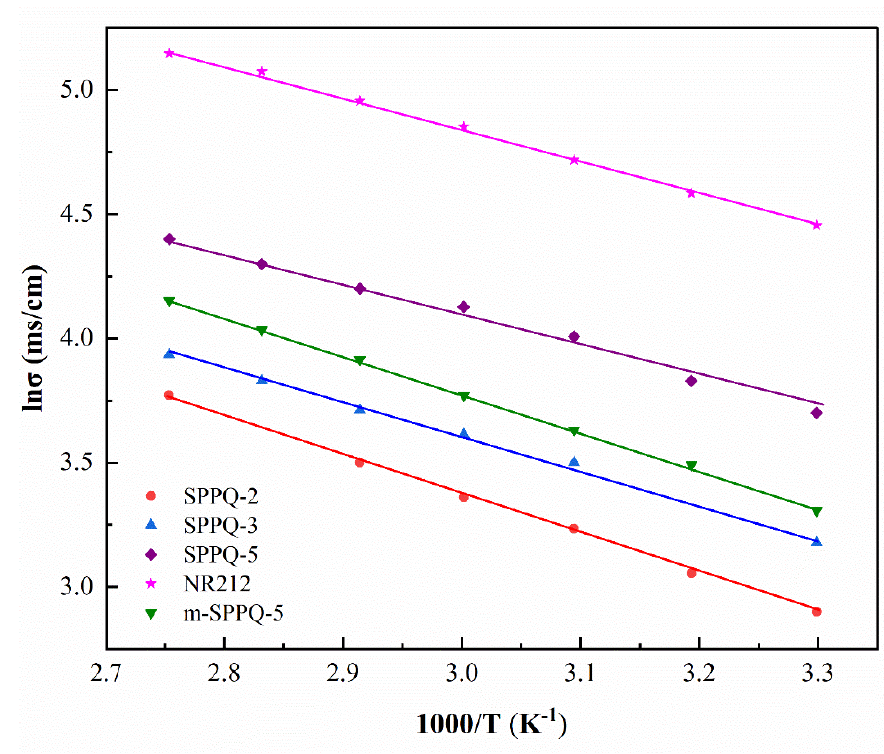
Figure 8. Temperature dependence of proton conductivity of membranes .